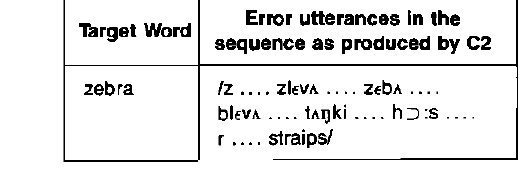
Table 4 An example of the use of semantic associations to recall the target item 'zebra' by F.T. Target